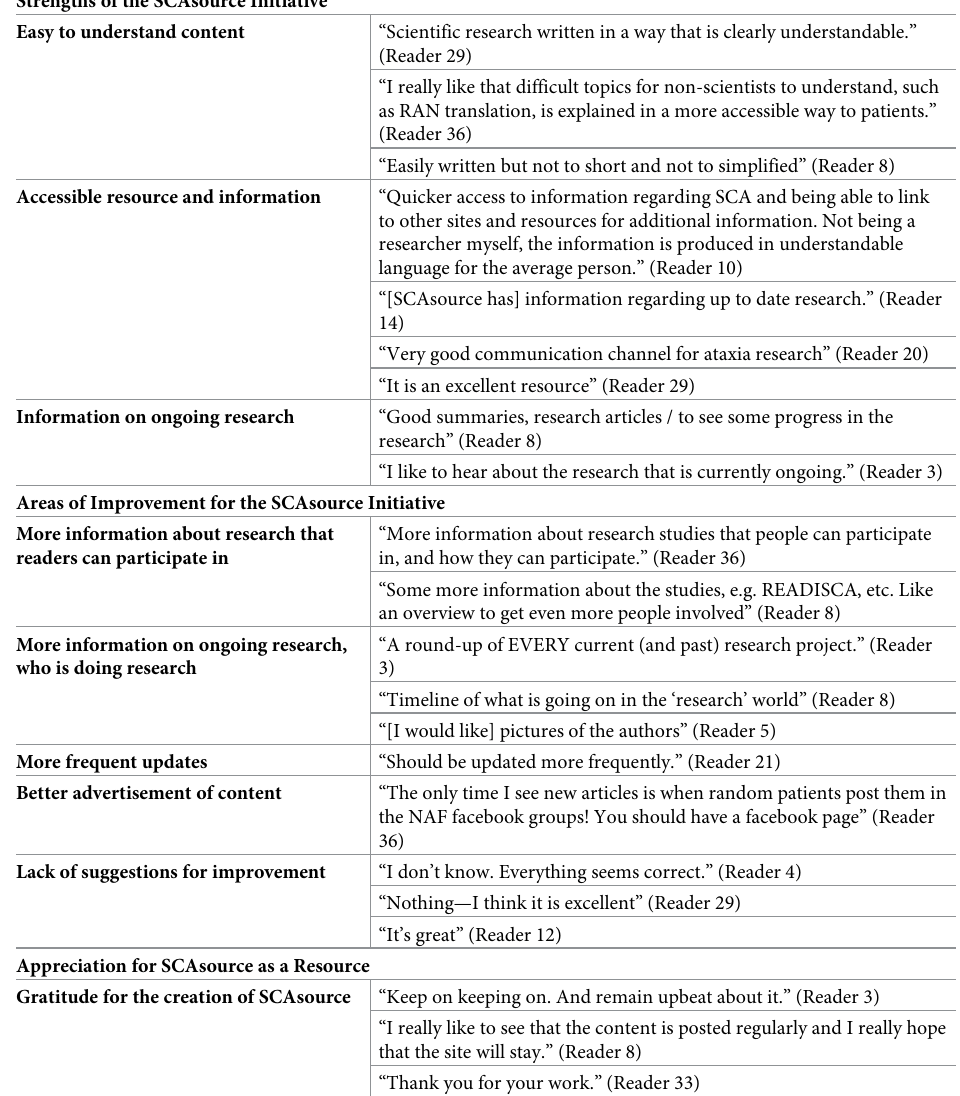
Table 4. Reader themes and representative